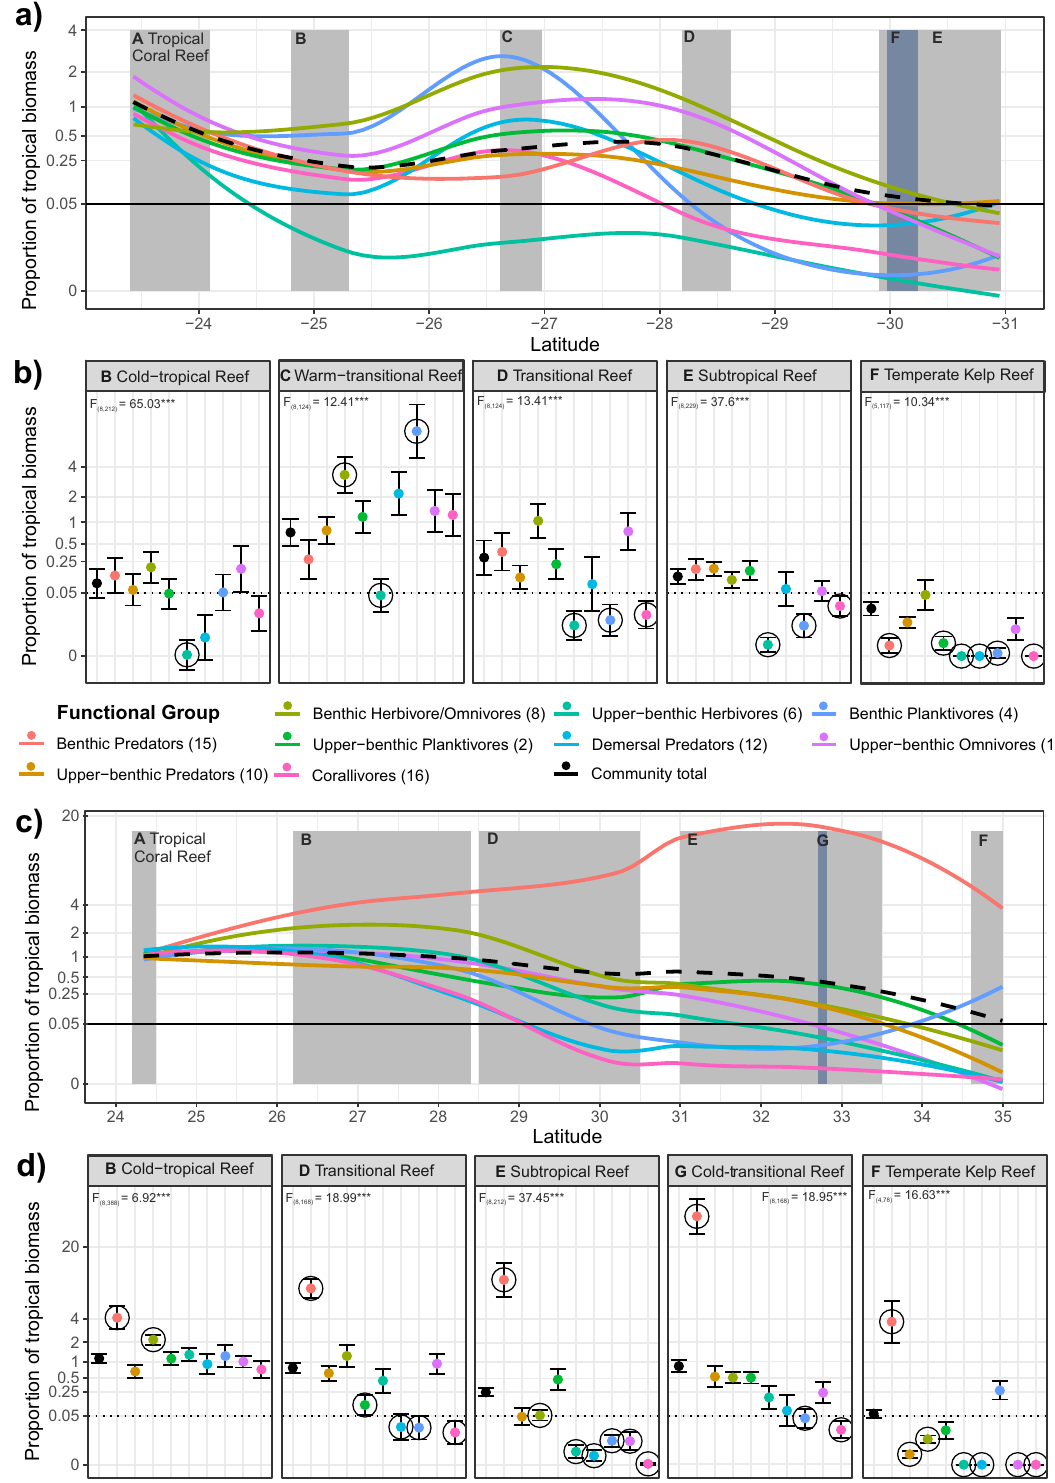
Fig.3|Tropicalisationfootprintsin fi shcommunities. Tropicalisationfootprints (proportion of tropical biomass relative to that of the Tropical Coral Reef zone) in Japan ( a , b ) and Australia ( c , d ) for nine functional groups (coloured) and the community total (black; dashed). a , c show change in tropicalisation footprints acrosslatitudeestimatedbyLoesssmoothers fi ttedtotransectleveldata. b , d show tropicalisation footprints (mean±s.e.) estimated by linear mixed models within